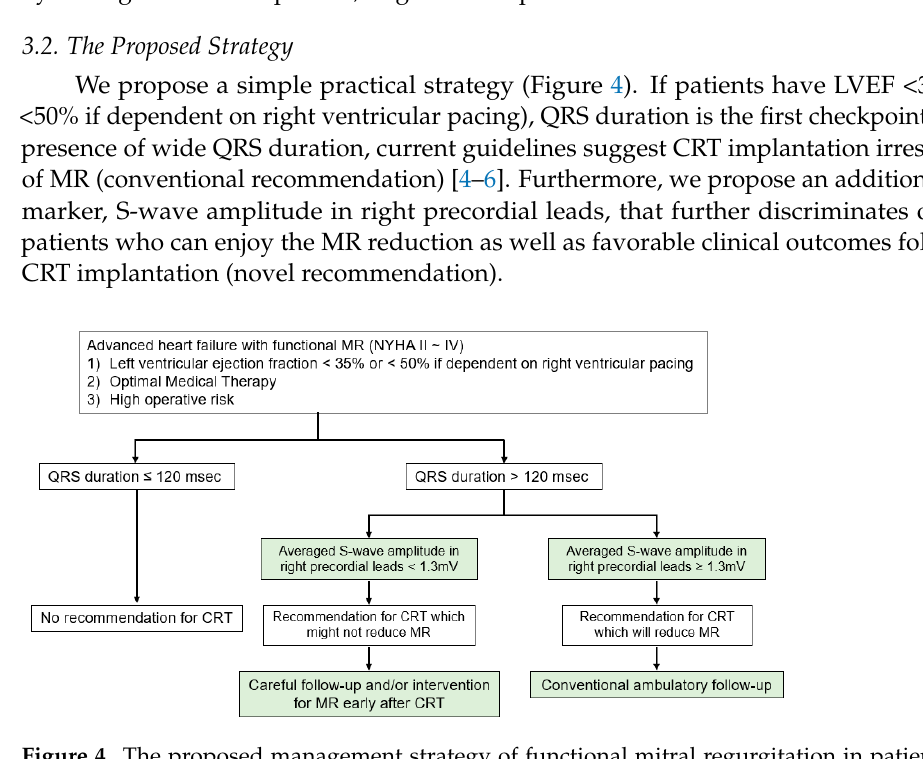
Figure 4. The proposed management strategy of functional mitral regurgitation in patients with advanced heart failure. CRT = cardiac resynchronization therapy and MR = mitral regurgitation.